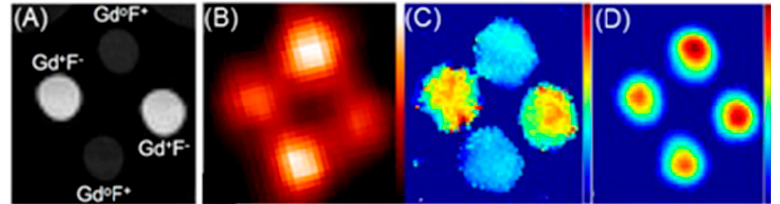
Figure 17. Imaging studies to detect hypoxia using T 1 -weighted MRI, PET, and EPRI. ( A ) T 1 - weighted MRI representing the presence and absence of Gd III -diethylenetriaminepentaacetic acid (defined in this example as Gd), and the presence or absence of 18 F. The two variants of PET/EPRI imaging solution include: 1 mM of dFT, 1 mM of Gd and 25 μ Ci of 6 (defined as the Gd + F – solution), and 1 mM of dFT and 49 μ Ci of 6 (defined as the Gd o F + solution). ( B ) PET image intensity is related to the concentration of 6 . ( C ) EPR image of Lorentzian line width, and ( D ) EPR image of dFT con- centration. Image intensity is related to dFT concentration. Adapted with permission of IOP Pub- lishing, Ltd., from A combined positron emission tomography (PET)-electron paramagnetic reso- nance imaging (EPRI) system: initial evaluation of a prototype scanner, Tseytlin, M.; Stolin, A. V.; Guggilapu, P.; Bobko, A. A.; Khramtsov, V. V.; Tseytlin, O.; Raylman, R. R. 63 , 2018 ; permission conveyed through Copyright Clearance Center, Inc.